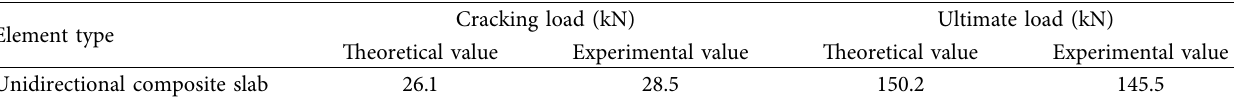
Figure 20: Deflection/load relation curves at different measuring points in the midspan of LPCSHTHSC along the long-span direction. Table 10: Comparative analysis of cracking load and ultimate load of